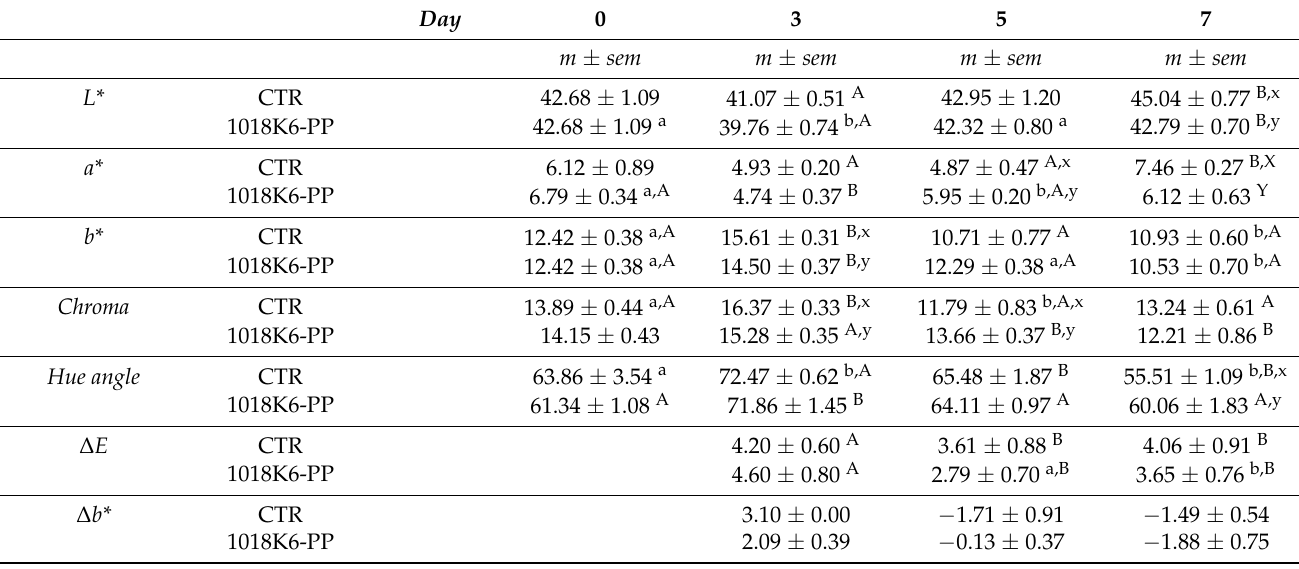
In each sampling day, three samples were analysed by experimental group. Statistical analysis was performed comparing experimental groups at each sampling time and within each experimental group along the ripening period. All data were presented as mean (m) ± standard error (sem). Different superscript uppercase letters indicate a significant difference at p < 0.01. Different superscript lowercase letters indicate a significant difference at p < 0.05. a,b In the same row mean values (same group in different days) followed by different letters show significant differences. x,y In the same column mean values (different groups on the same sampling time) followed by different letters show significant differences.